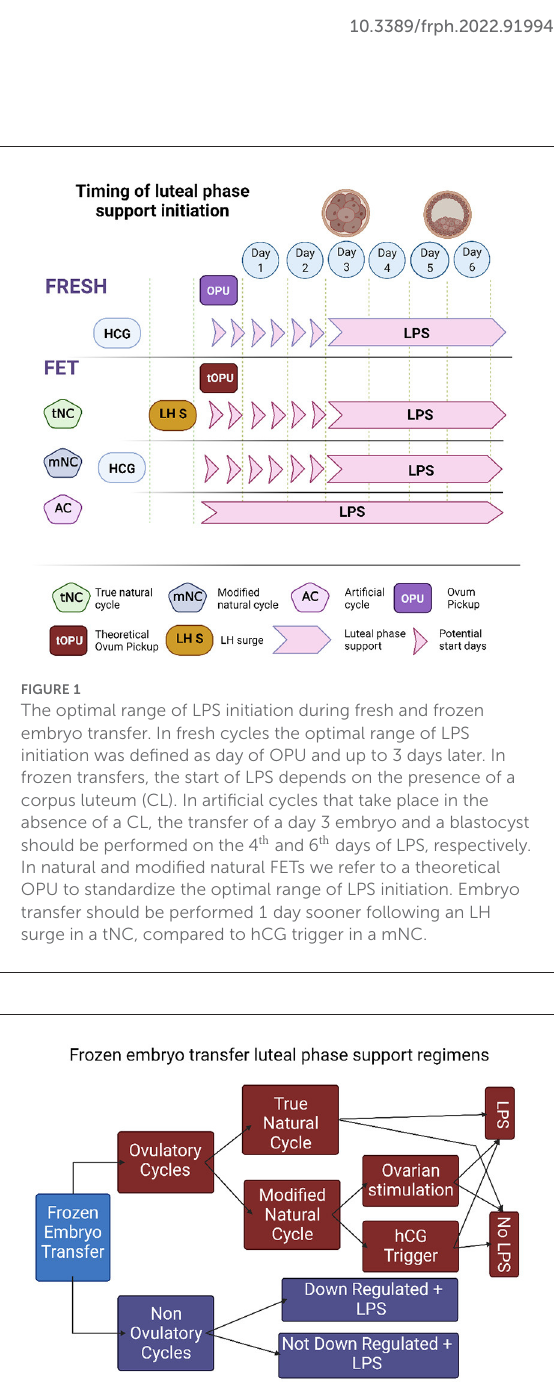
FIGURE2 The types of frozen embryo transfer protocols. (FET, frozen embryo transfer; NC, natural cycle; COH, controlled ovarian hyperstimulation; tNC, true natural cycle; mNC, modified natural cycle; LPS, luteal phase